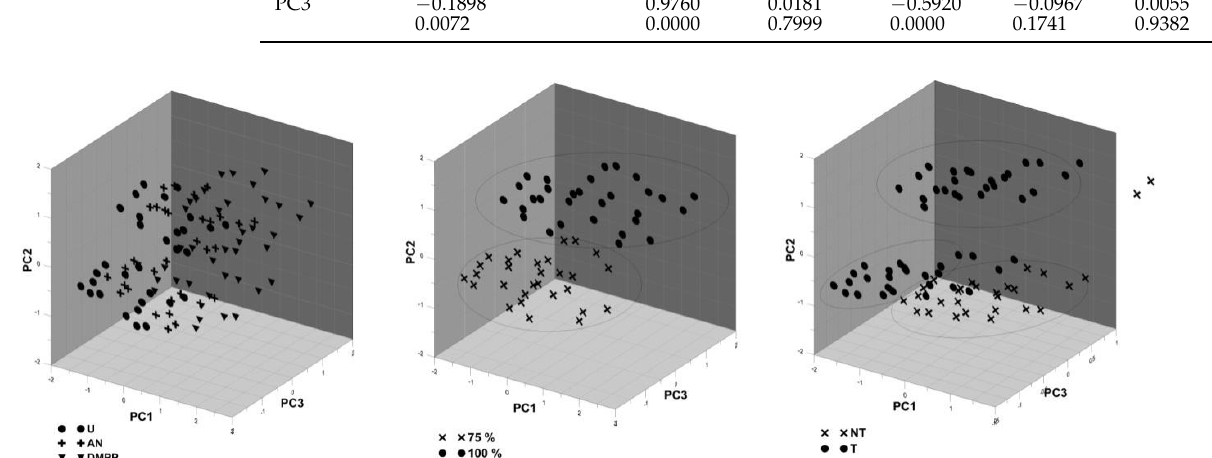
Figure 5. Spatial representation of the main components for each variable studied independently.